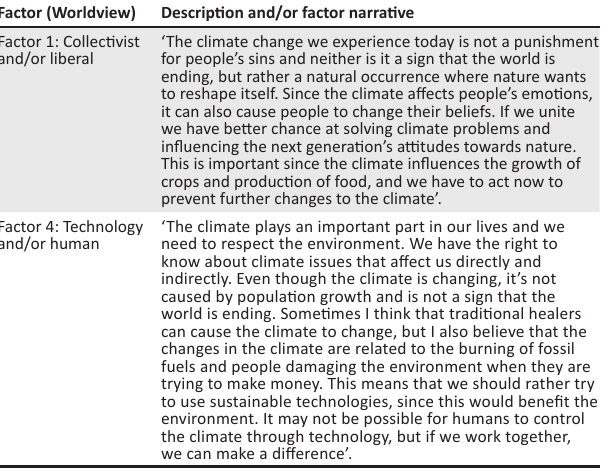
TABLE 1: Narrative description of factor arrays 1 and 4. Factor (Worldview) Description and/or factor narrative